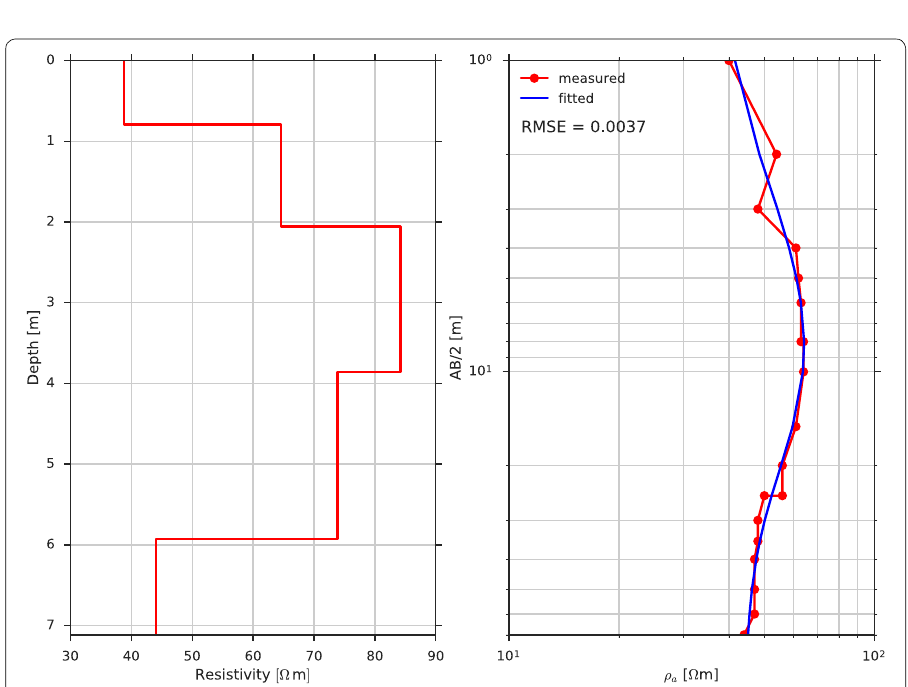
Fig. 10 Vertical Electrical Sounding data point inversion example. The right graph shows the measured electrical resistivities given by Ohm’s law for different distances between electrodes A and B in red and the forward model resulting from the inversion in blue ( ρ a is the apparent resistivity, and the RMSE between the two set of values is specified); the left graph shows the resulting depths and resistivities of the ground layers obtained from the